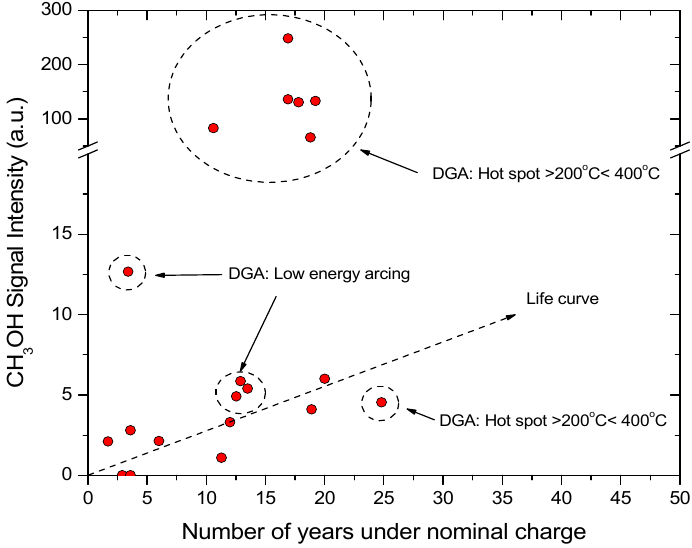
Figure 11. Insulation transformer life curve using methanol [2].